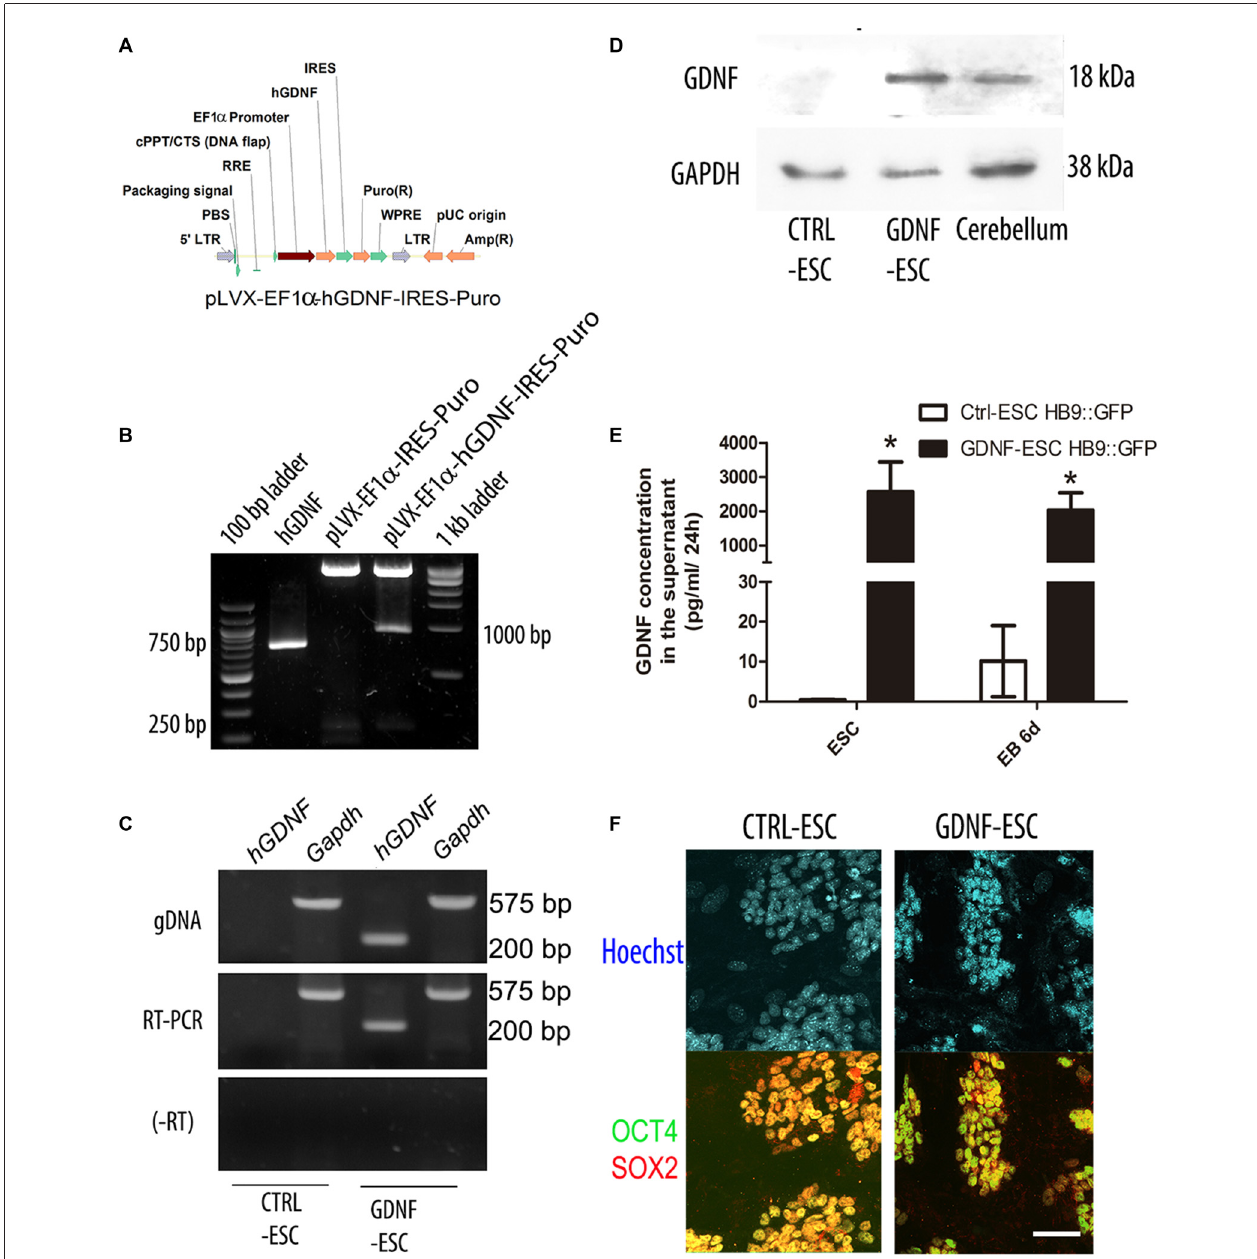
FIGURE 1 | Generation of transgenic mouse embryonic stem cells (mESC) that release glial cell-derived neurotrophic factor (GDNF) to the medium and retain pluripotency. (A) Scheme of the EF1 α ::human GDNF (hGDNF) lentiviral construct. (B) Ligation of the hGDNF complementary DNA (cDNA; lane 2) into the lentiviral vector (lane 3) to produce the pLVX-EF1 α -hGDNF-IRES-Puro plasmid (lane 4). (C) Genotyping (by endpoint PCR) and mRNA expression (by RT-PCR) after lentiviral transduction of ESC. RNA without retrotranscription (-RT). (D) Western blot to detect GDNF in cell lysates. Cerebellum was used as a positive control. GAPDH as a loading control (E) Quantification of GDNF by ELISA in conditioned media in undifferentiated ESC and differentiation embryoid bodies (EBs; white bars reflect mGDNF). ∗ p < 0.001 vs. CTRL-ESC at the same stage. (F) Immunofluorescence for the pluripotency factors Sox2 and Oct4 in CTRL- and GDNF-ESC transgenic lines. Scale bar: 50 µ